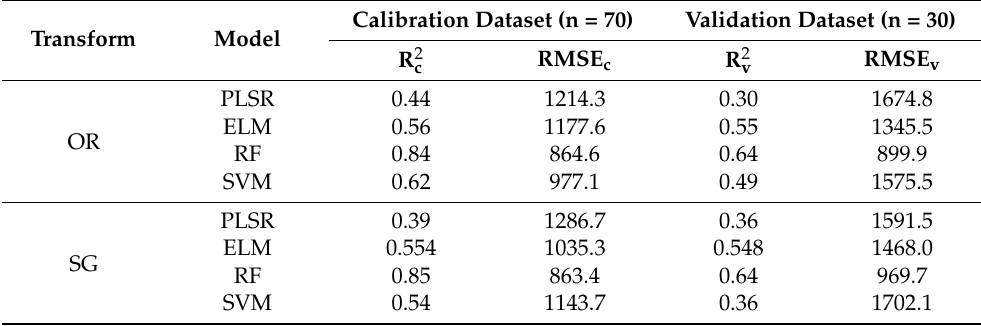
Table 3. Accuracy evaluation for inferring Fe concentration using PLSR, ELM, RF, and SVM models based on OR and SG transformation.